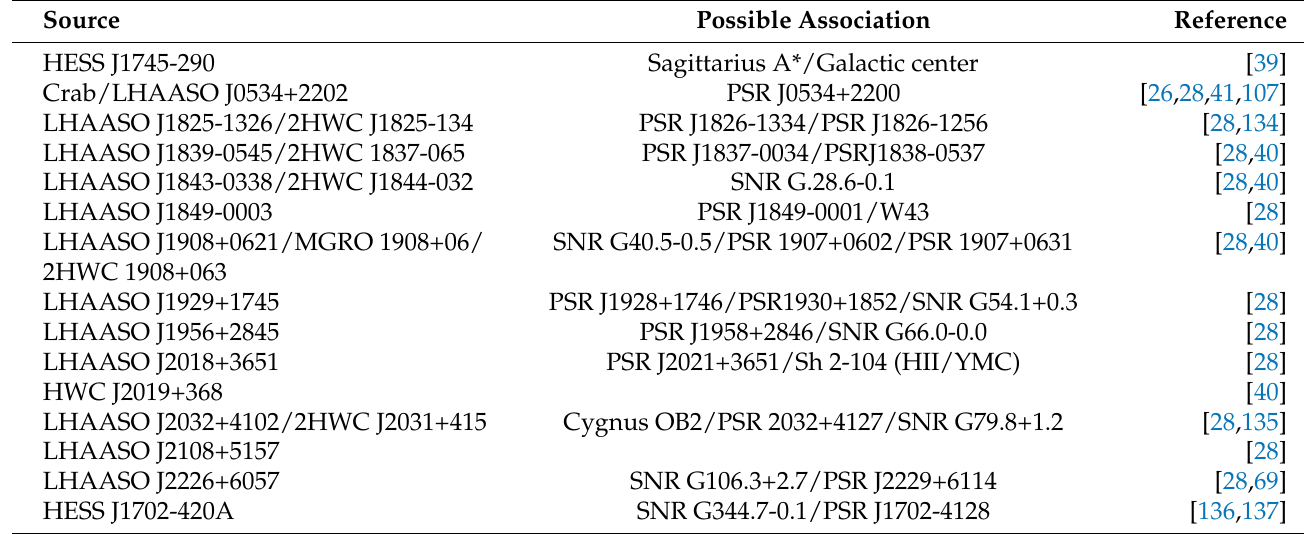
Table 1. List of known Galactic pevatrons as of May 2021. This list is likely to be lengthened soon due to active ongoing detection